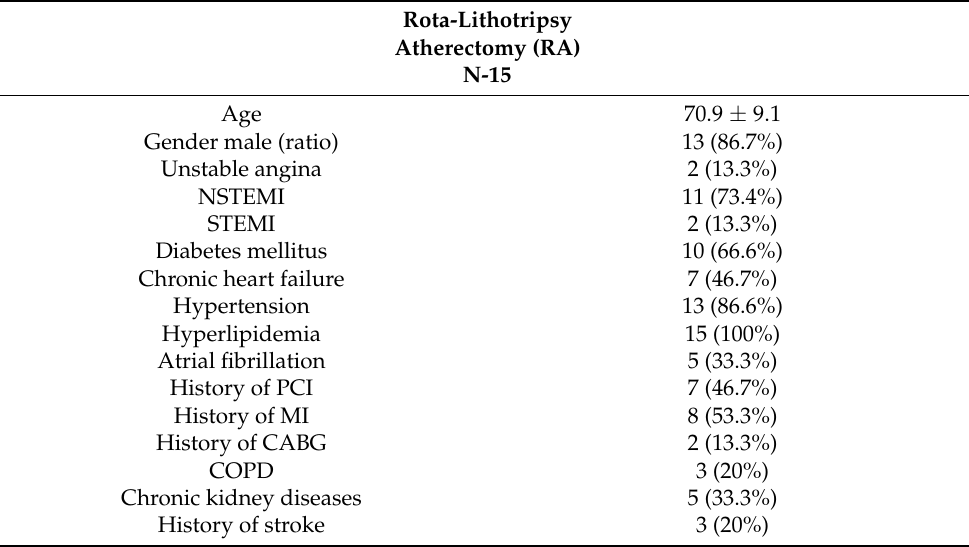
Table 1. The baseline clinical characteristics of the study